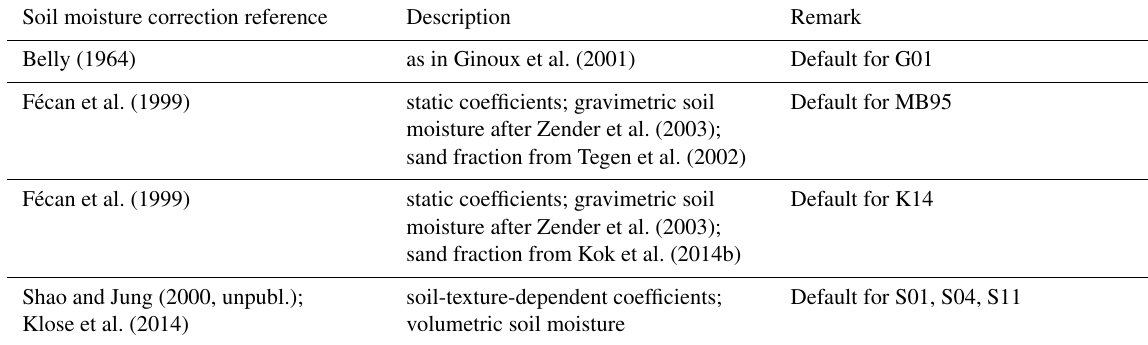
Table 4. Summary of available options in MONARCH to account for soil moisture in the particle entrainment threshold. Soil moisture correction reference Description